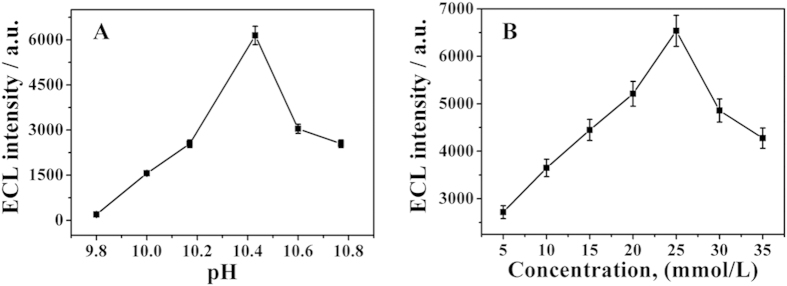
The effect of pH (A) and concentration of H2O2 (B). Error bar = SD (n = 3).